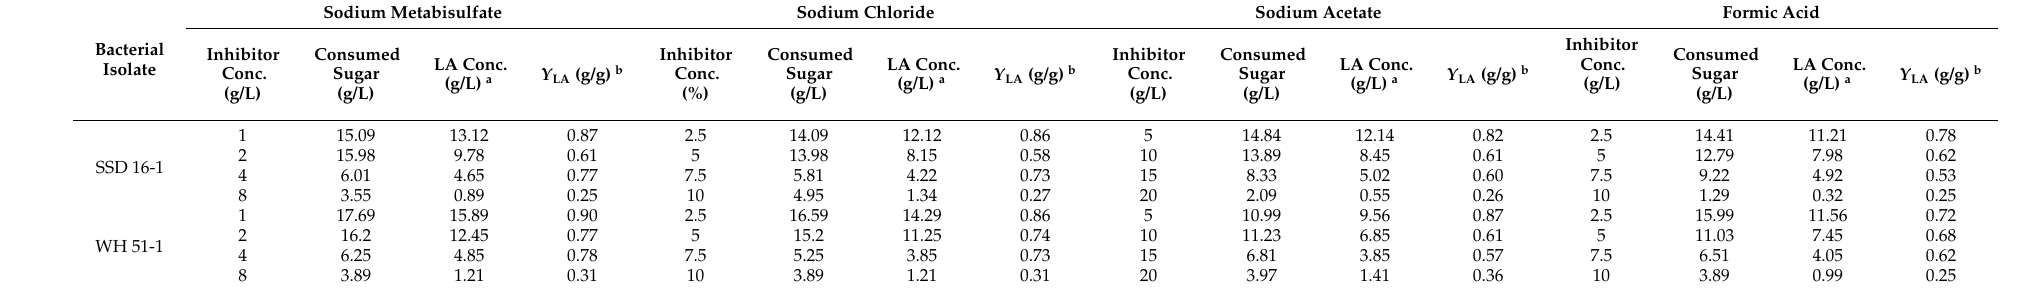
Table 4. Effect of different inhibitory compounds on sugar consumption, LA concentration, and LA yield by the two most potent selected isolates. Sodium Metabisulfate Sodium Chloride Sodium Acetate Formic Acid Bacterial Inhibitor Isolate